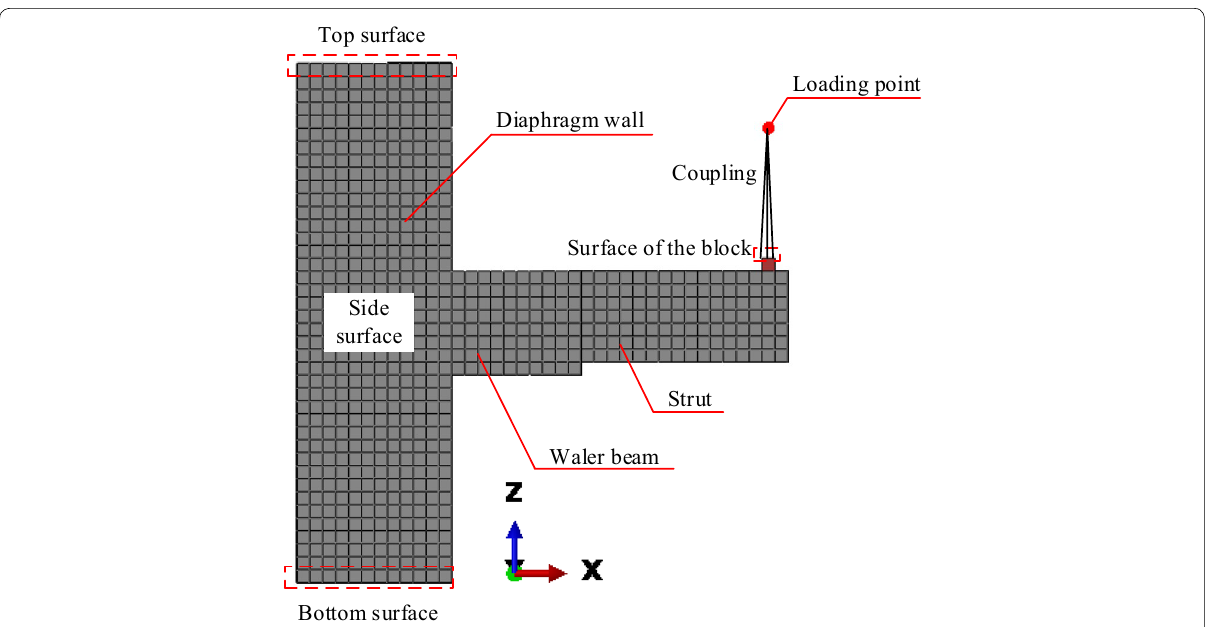
Fig. 14 Side view of the numerical model.